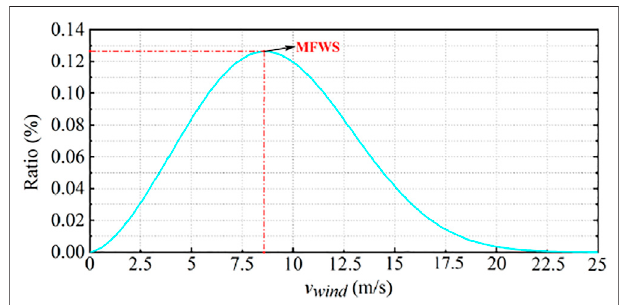
FIGURE 2 | Wind speed – frequency distribution. FIGURE 3 | Capacitor voltage under different wind speeds.